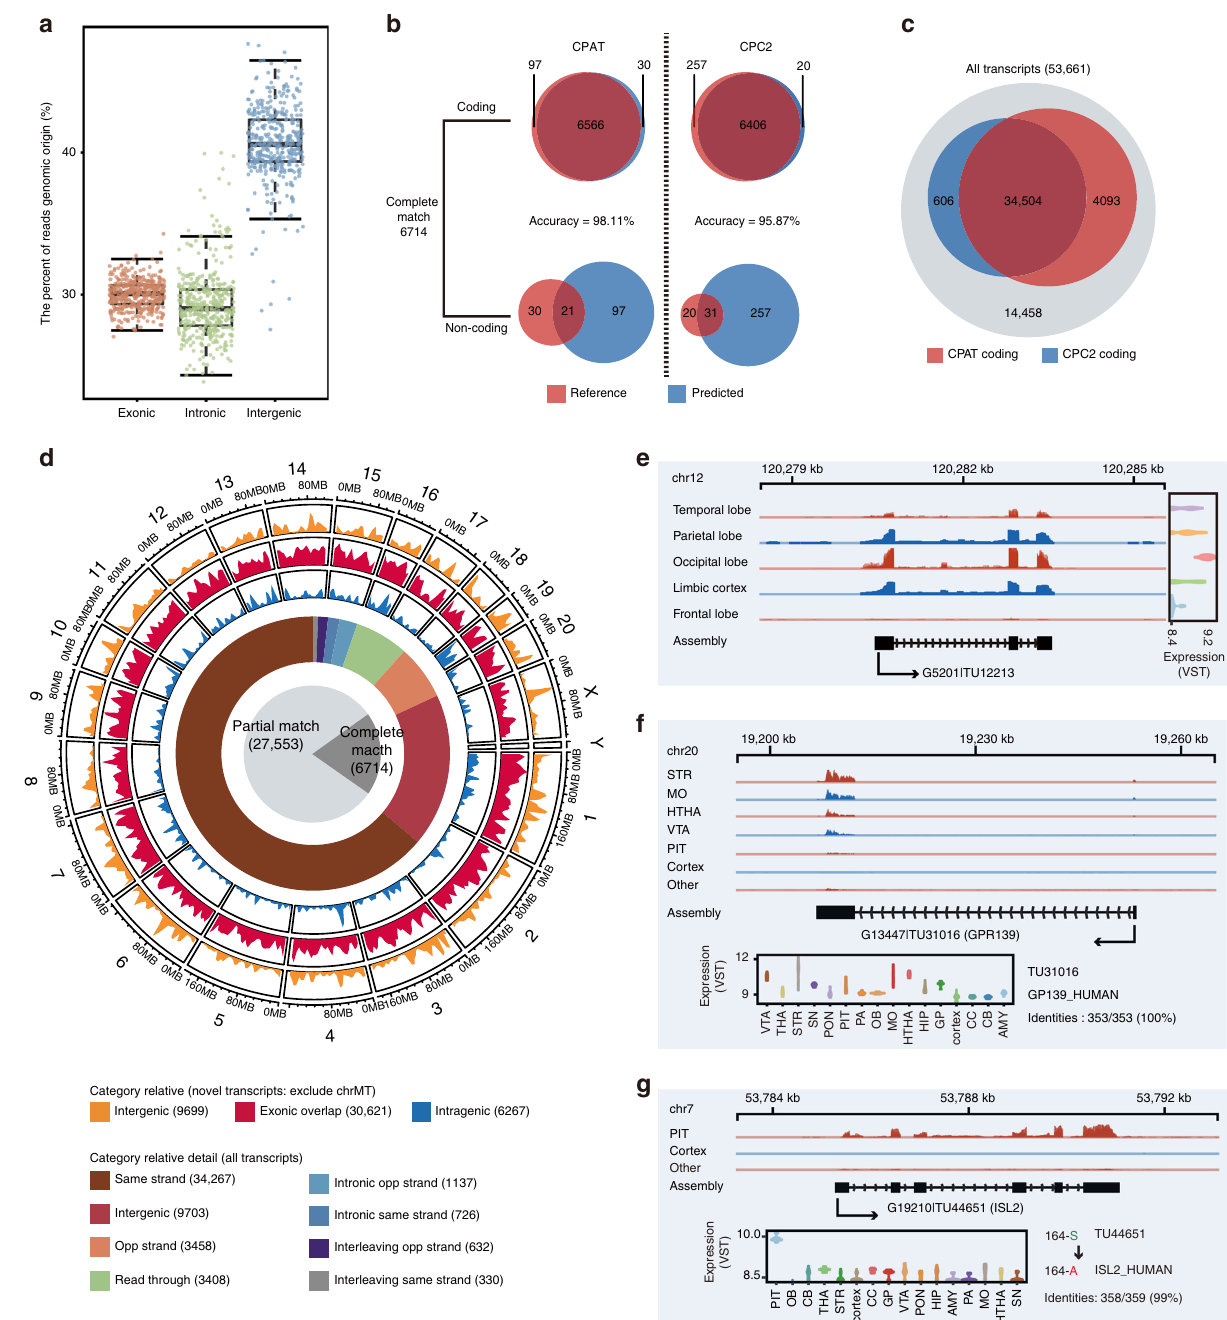
Fig. 4 Novel transcripts related to brain regions and individuals. a Boxplot showing the percentage of RNA-seq reads mapped to different genomic regions on the rhesus macaque genome. In boxplots, center line, box edges, whiskers, and points indicate the median, upper, and lower quartiles (the 25th and 75th percentiles), 1.5 × interquartile range and outlier, respectively. b Venn plot showing the accuracy of CPAT and CPC2 predicted coding potential comparing with the reference transcripts. c Venn plot showing the number of coding transcripts with coding potential predicted by CPAT and CPC2. d Circos plot shows the distribution of assembly transcripts. The pie chart shows 12.51% transcripts were complete match with reference transcripts. The donut chart shows the composition of the assembled transcripts relative to reference transcripts. The three circles of area charts indicate density of novel intergenic (orange), exonic_overlap (red), and intragenic (blue) transcripts on the genome, respectively. e Genome browser view showing lobe-related expression of novel transcript TU12213. f Genome browser view showing subregion-related expression of novel transcript TU31016 that is homologous with human protein GPR139. g Genome browser view showing subregion-speci fi c expression of novel transcript TU44651, located on chromosome